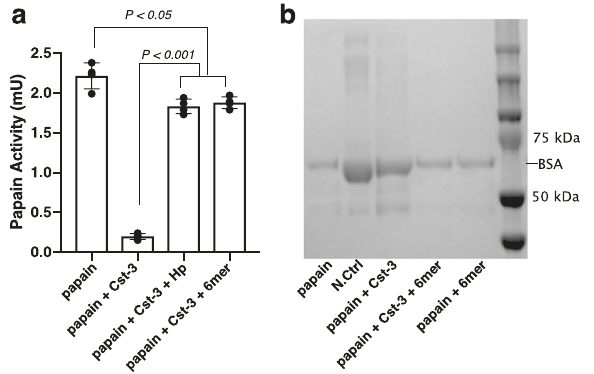
Fig. 7 HS interferes with the biological function of Cst-3. a The enzymatic activity of papain was determined by using a colorimetric peptide substrate in the presence or absence of Cst-3, and in the presence or absence of HS hexasaccharide (6mer) and heparin (Hp). n = 4. b Heat-denatured BSA was digested with papain in the presence or absence of Cst-3, and/or in the presence or absence of HS 6mer. N.Ctrl lane was run with only denatured BSA. Data are representative of at least three similar